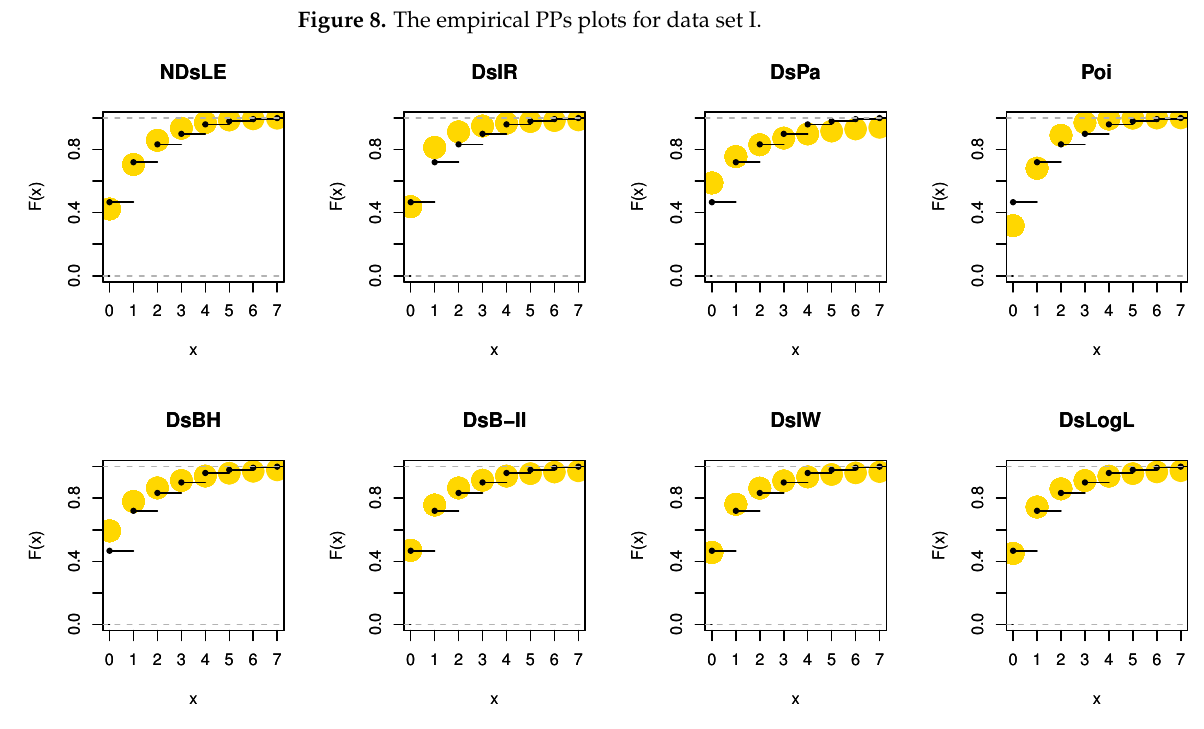
Figure 9. The empirical CDFs plots for data set I. Table 7 lists different estimators for data set I, and it was found that the MLE and MoE techniques worked quite well for modeling data set